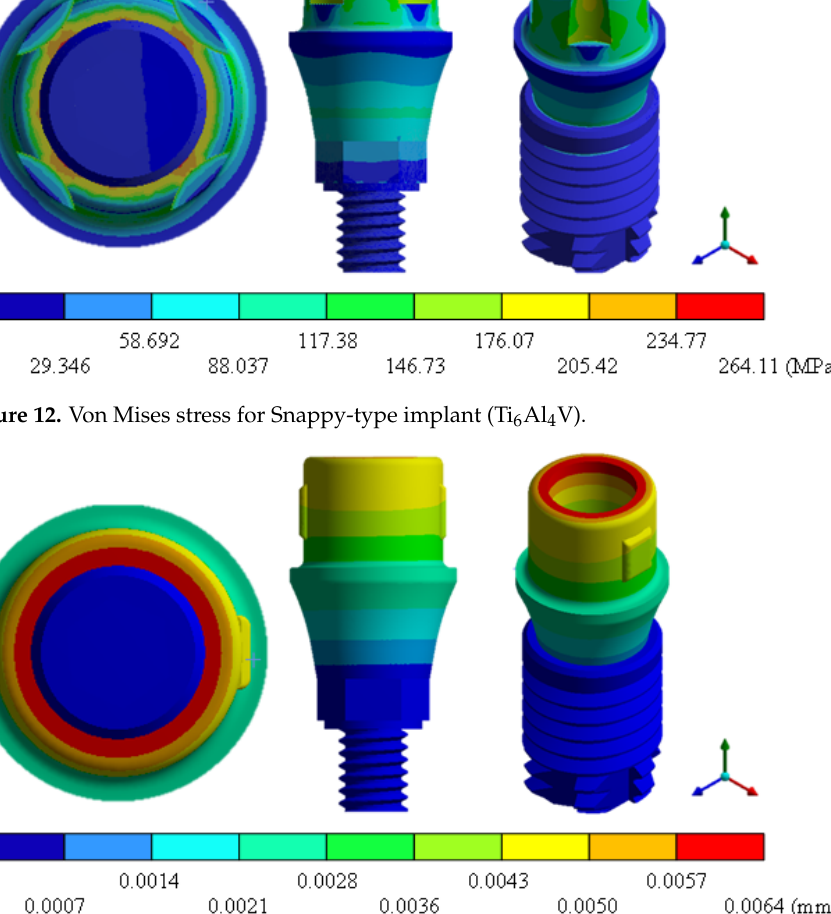
Figure 13. Total general displacement for Universal-type implant (Ti 6 Al 4